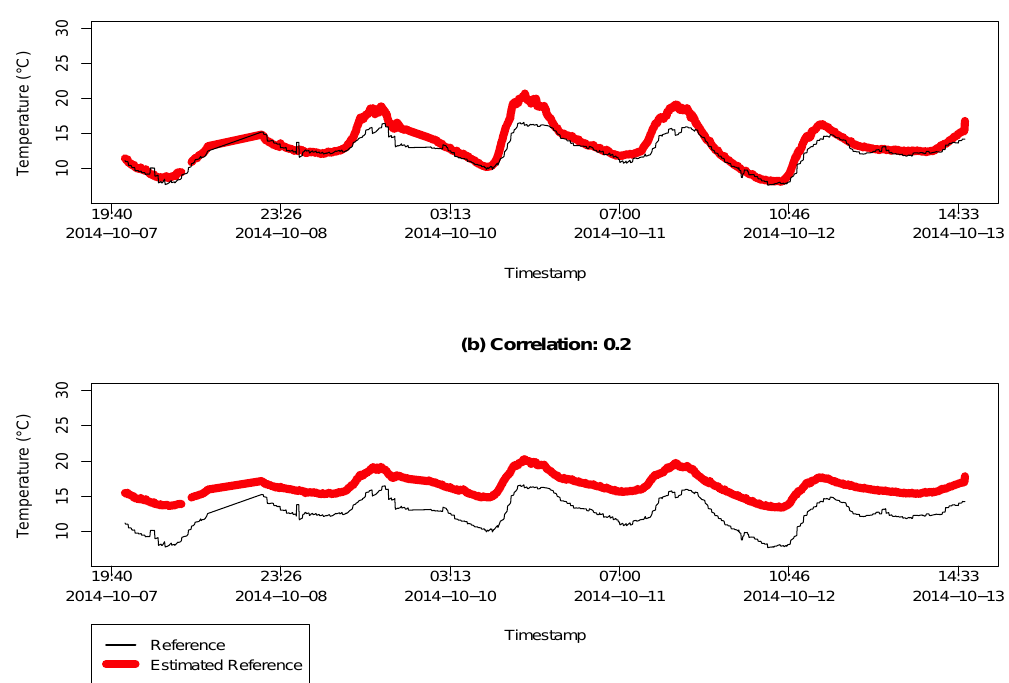
Figure 12. Estimation of the temperature ˆ θ for two different correlation limits in a range of 100 km from the coordinates of London, UK, in Dataset 2: ( a ) for sensors with correlation r ≥ 0 . 8 with MSE = 2 . 045454 ; and ( b ) for sensors with correlation r ≥ 0 . 2 with MSE = 15 . 63293